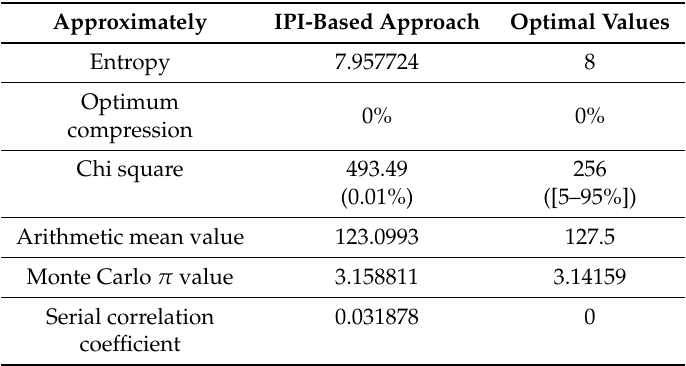
Table 1. ENT results (10-MB file with 4-LSB Inter-Pulse-Interval (IPI)